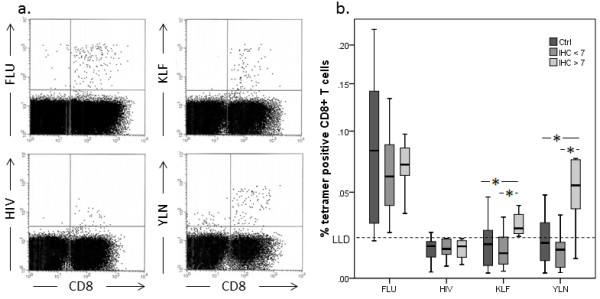
Mean frequencies of CD8+ EGFR-specific T cells in HNSCC patients and healthy controls. Representative dot plots for tetramer staining are displayed (a). Results are displayed in percent (%) for the control staining with FLU- and HIV-specific tetramers, as well as the EGFR-specific pentamer KLF and tetramer YLN. For both EGFR-specific peptides, HNSCC patients with a high EGFR score (> 7) had a significantly elevated frequency of EGFR-specific CTL, compared to patients with low EGFR score (< 7) and normal donors (* p-value < 0.05). No significant difference was seen between normal donors and patients with low EGFR score (b).